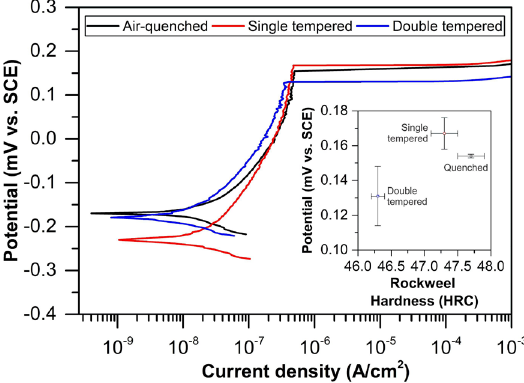
Figure 10. Potentiodynamic polarization curves of the samples after air-quenching, single tempering and double tempering treatments and the correlation between hardness and E pit .